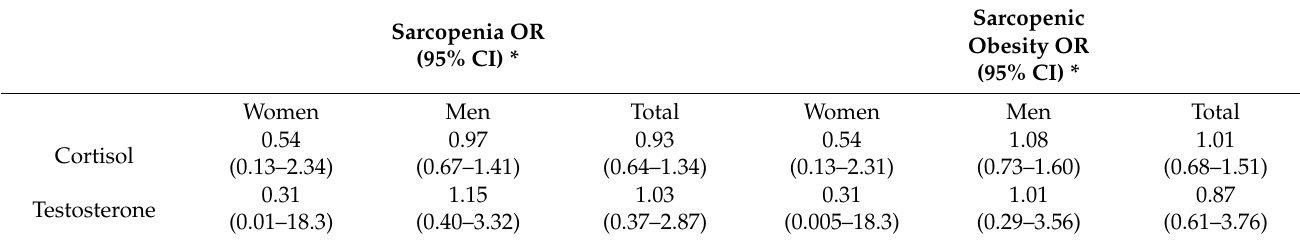
Table 7. Logistic regression for the prediction of changes in the probability of sarcopenia and sarcopenic obesity associated with changes in cortisol and/or testosterone.